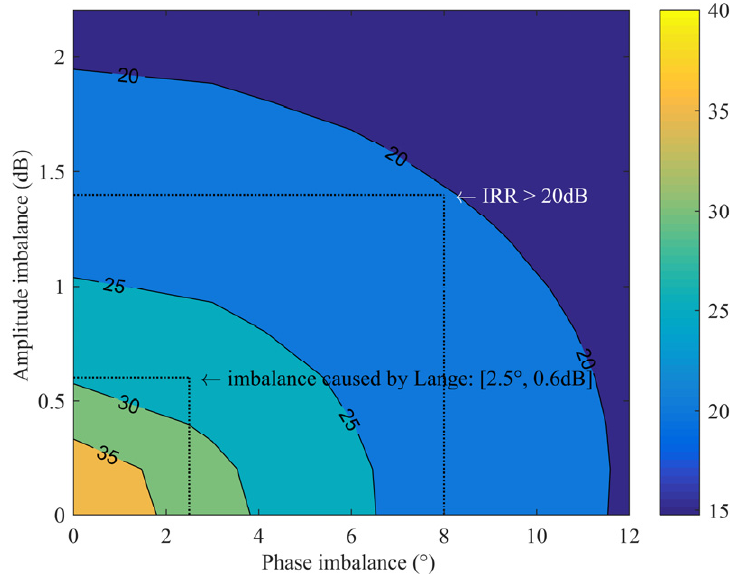
Figure 2. Relationship between the IRR and I/Q amplitude phase imbalance.